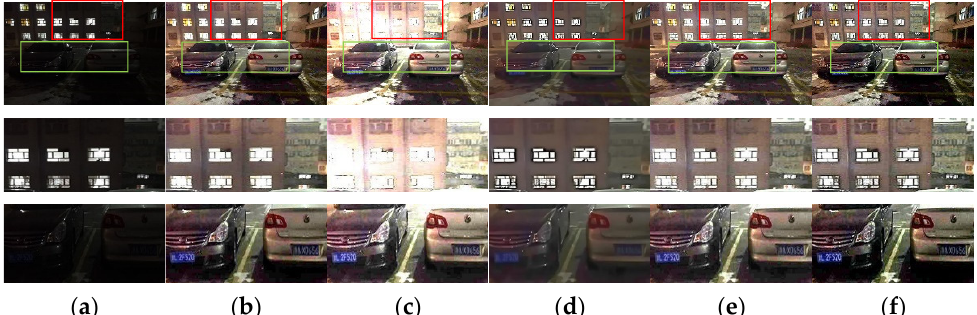
Figure 12. ( a ) Test image and its detail maps. The remaining images are the enhancement results and their detail maps, generated by the following methods: ( b ) ALSM, ( c ) Li et al. [26], ( d ) LR3M, ( e ) LIME, and ( f ) the proposed method.